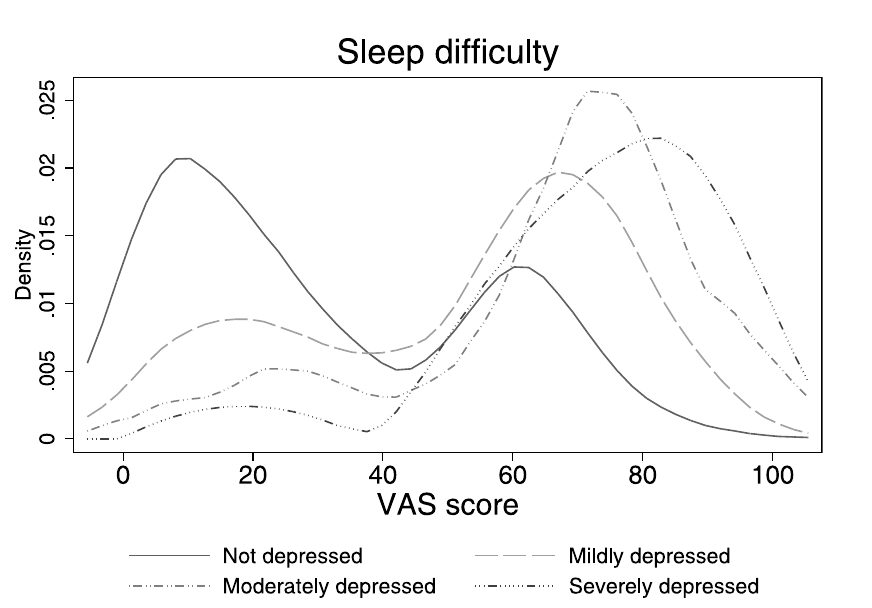
Fig 3. Distribution of sleep difficulty evaluations by depressive symptoms. Note : 0 means ‘no difficulty’ and 100 means ‘extreme difficulty’ with sleep.